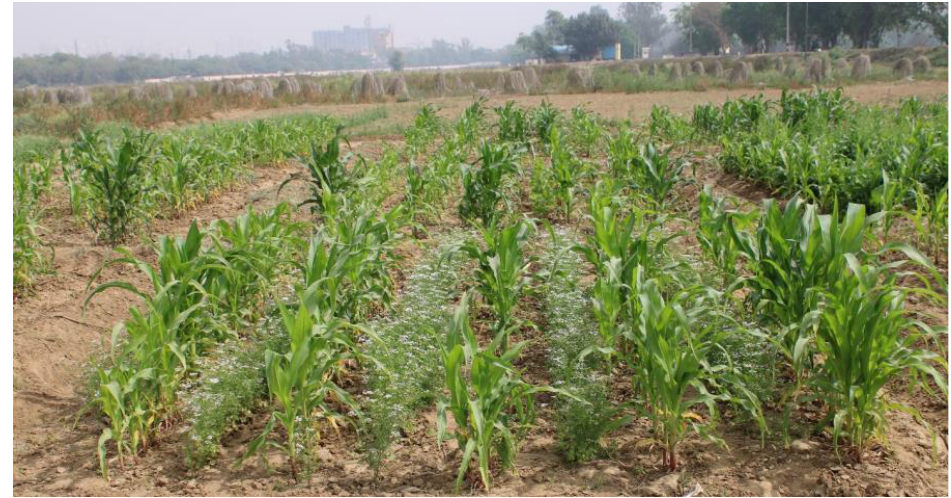
Figure 6. Maize + coriander, Coriander sativum intercropping system. Intercrops were sown in between the rows of maize in the intercropped plot. The total plants in each plot were observed for the damage signs during each week. The per- cent plant damage was calculated by dividing the total number of plants in the plot by the number of damaged plants. The leaf damage caused by S. frugiperda was assessed visually and scored on a 0 – 9 scale [61]. In addition, total numbers of plants having excreta were also recorded during each observed week. In the later growth stage, the total numbers of cobs damaged in each plot were noted. The yield of cobs in each plot was recorded, and the yield/acre was calculated by extrapolation.